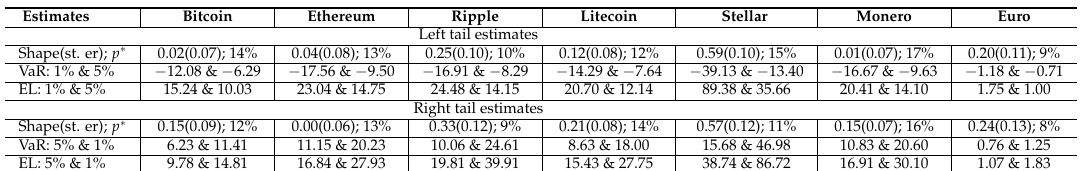
Table 2. GPD estimates and long-run risk measures: shape parameter (standard error); percentage of excesses p ∗ ; 1% and 5% VaR and expected loss (EL)